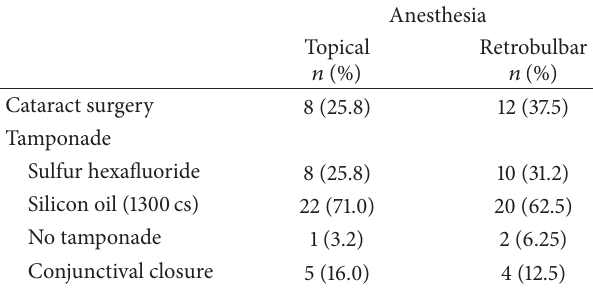
Table 3: Surgical properties by treatment assignment.